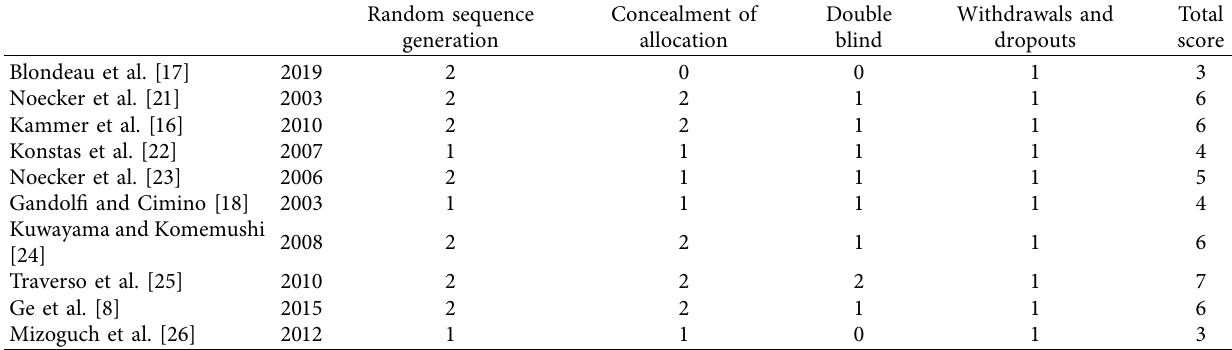
Table 2: Quality assessment of the included studies.